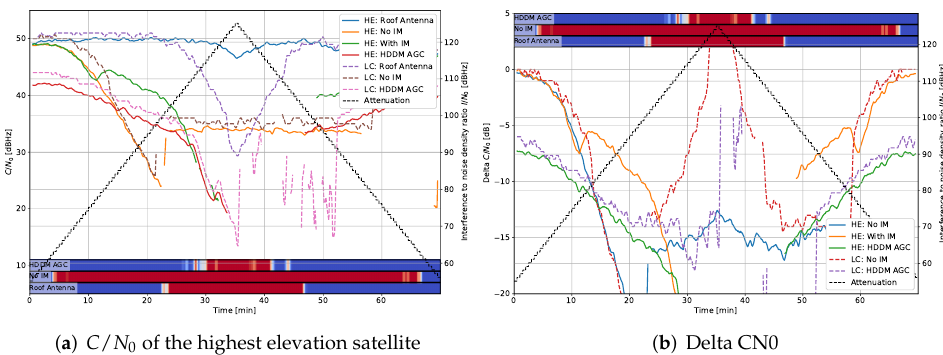
Figure A2. Interference #2: Fast Chirp 10 MHz with GPS L1/CA.